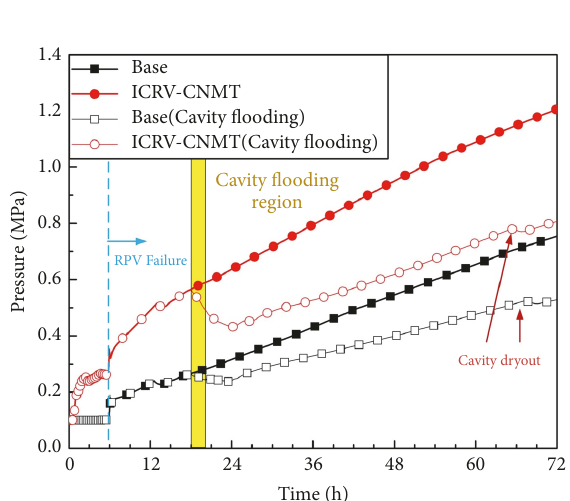
Figure 17: The steam mass of cavity flooding in